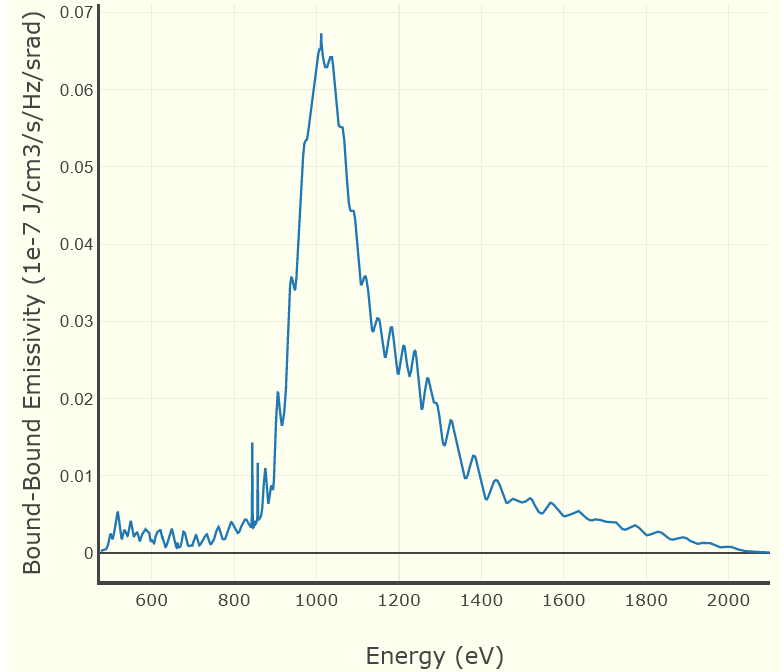
Figure 5. Bound-bound emissivity for a steady-state Xe plasma at 2000 eV and 10 18 cm − 3